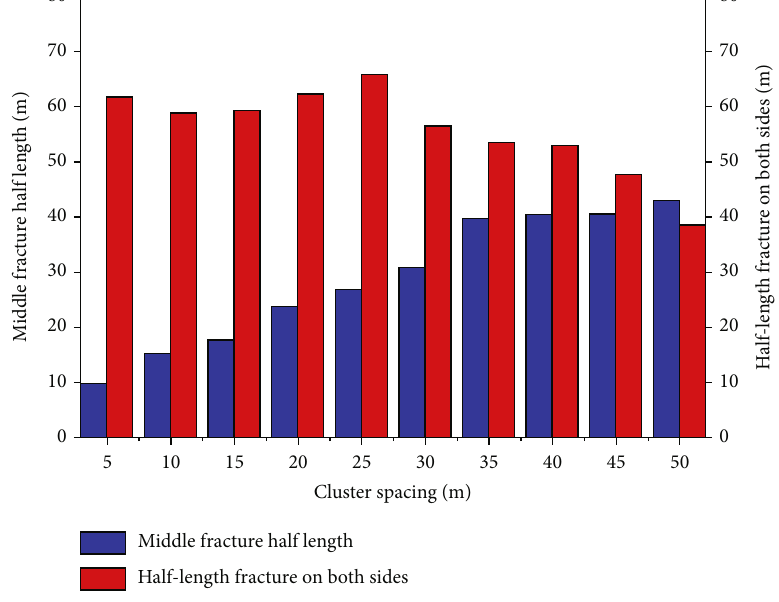
Figure 9: Variation of outer and middle fracture lengths with cluster